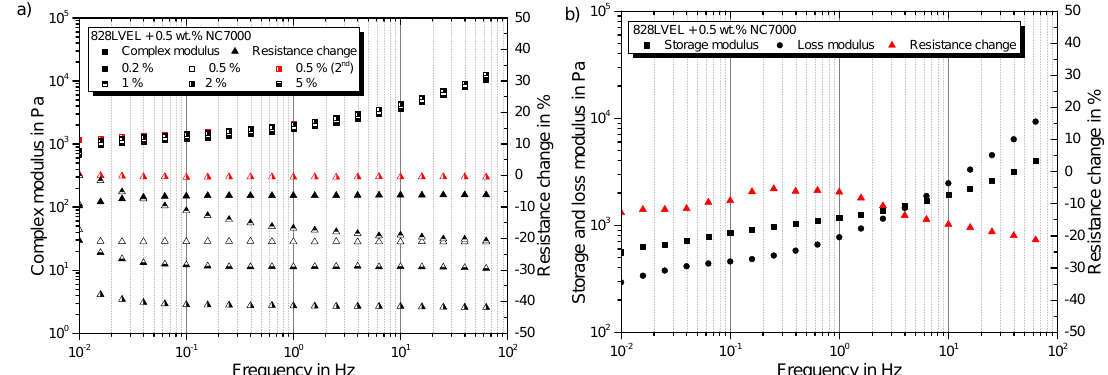
Figure 10. Frequency dependency of ( a ) complex modulus and resistance change and ( b ) storage, loss modulus and resistance change for a 20% strain